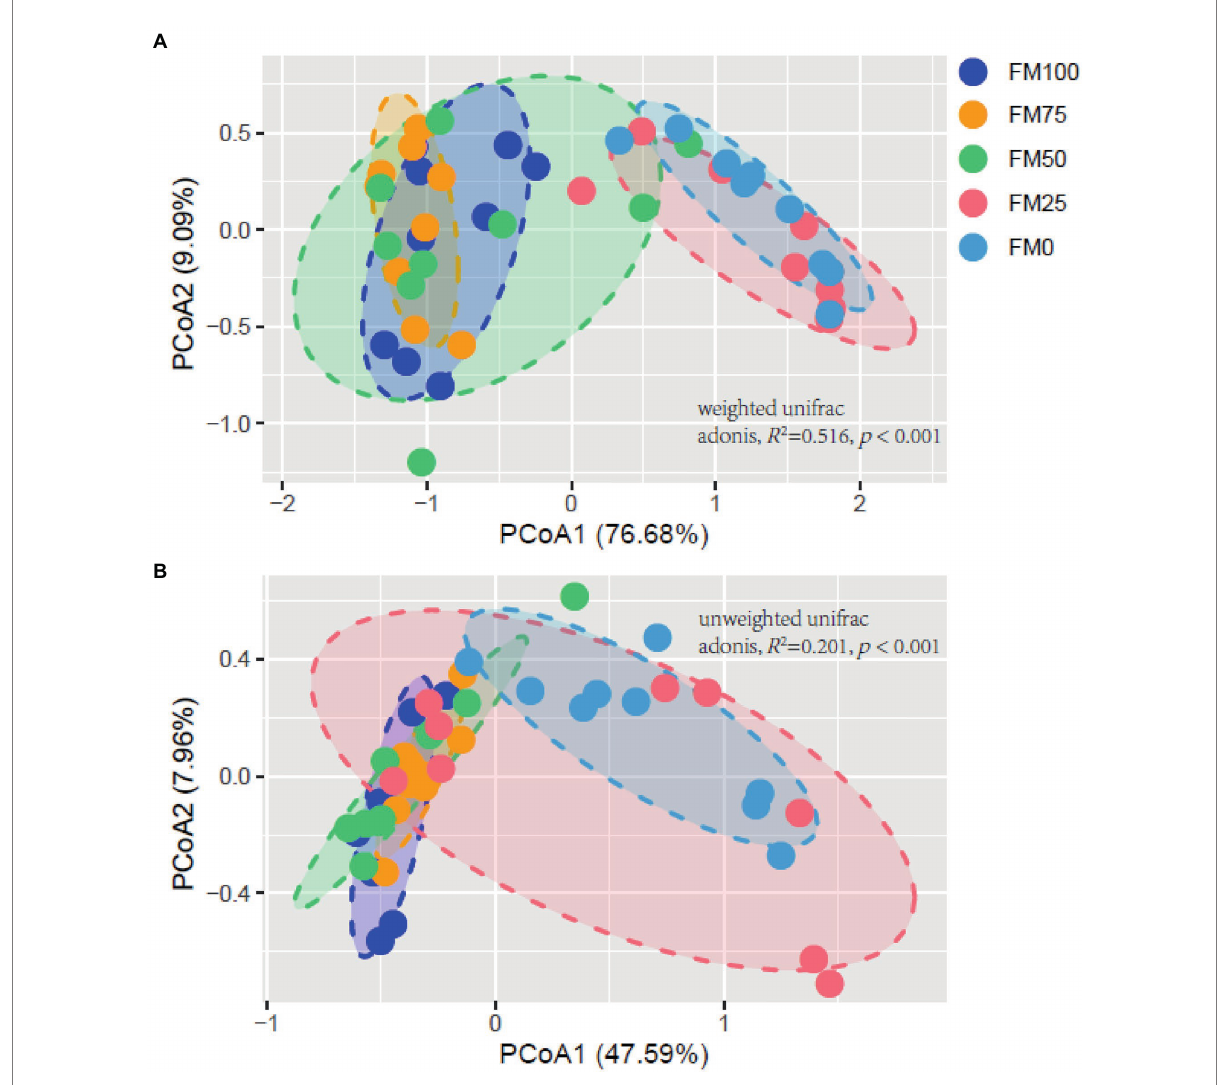
FIGURE 5 Principal Co-ordinate analysis diagrams (A) based on weighted unifrac distance and (B) based on unweighted unifrac distance showing the gut microbial distribution among the five groups of largemouth bass. FM100 represents the fishmeal diet without Chlorella meal; FM75, FM50, FM25, and FM0 represent the fishmeal diets with 25, 50, 75, and 100% fishmeal replacement by Chlorella meal,